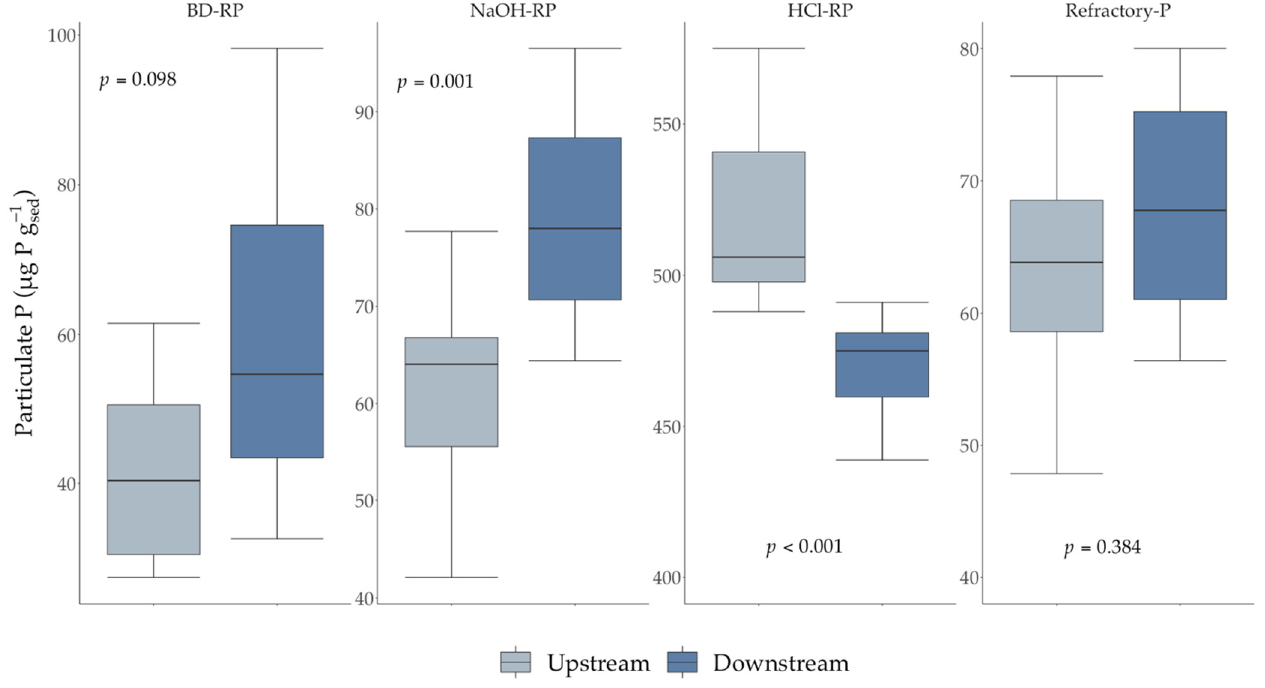
Figure 5. Concentrations of PP fractions of fine sediment stored in gravel-beds at upstream (S2, S3; n = 8) and downstream